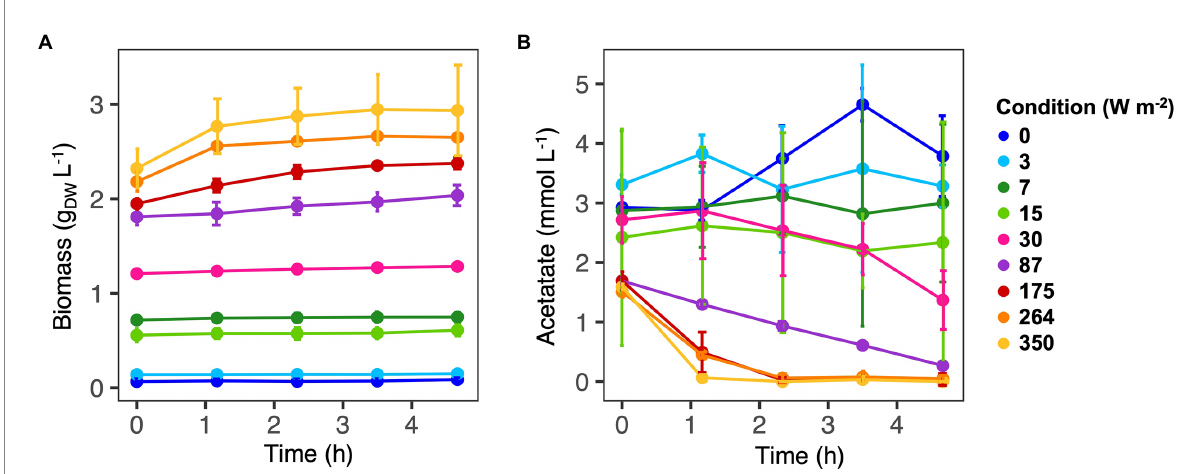
FIGURE 1 Biomass (A) and acetate (B) concentrations along the SBR cycles. Values are expressed as the average value for each time point. Samples were collected for three cycles. At high light intensities (350–87 W m − 2 ) acetate was fully consumed at the end of the reaction cycles. At low light